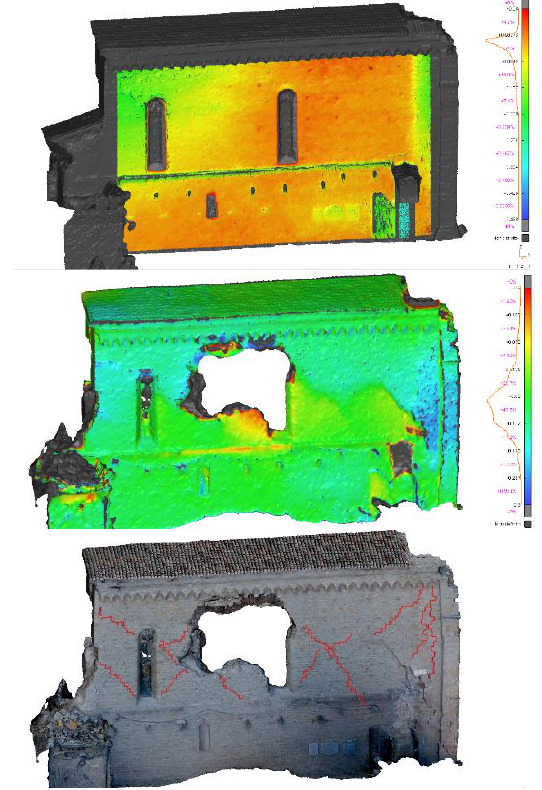
Figure 14. Orthoimages of the main façade in t1, t2, t3.